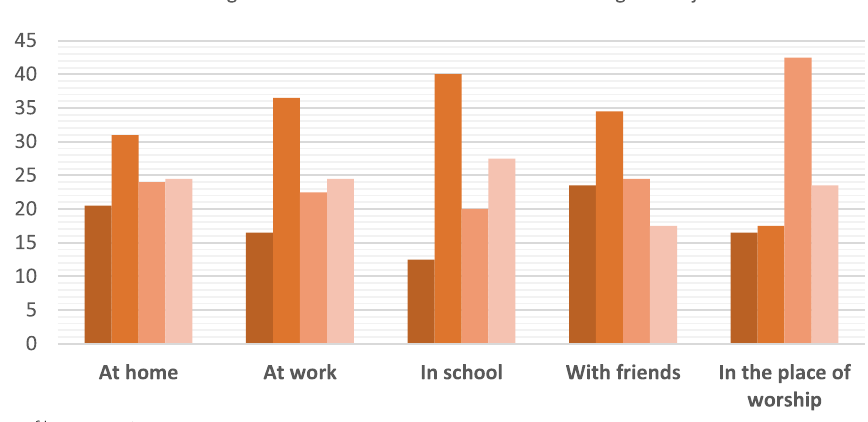
Fig. 10 Percentages of languages in use